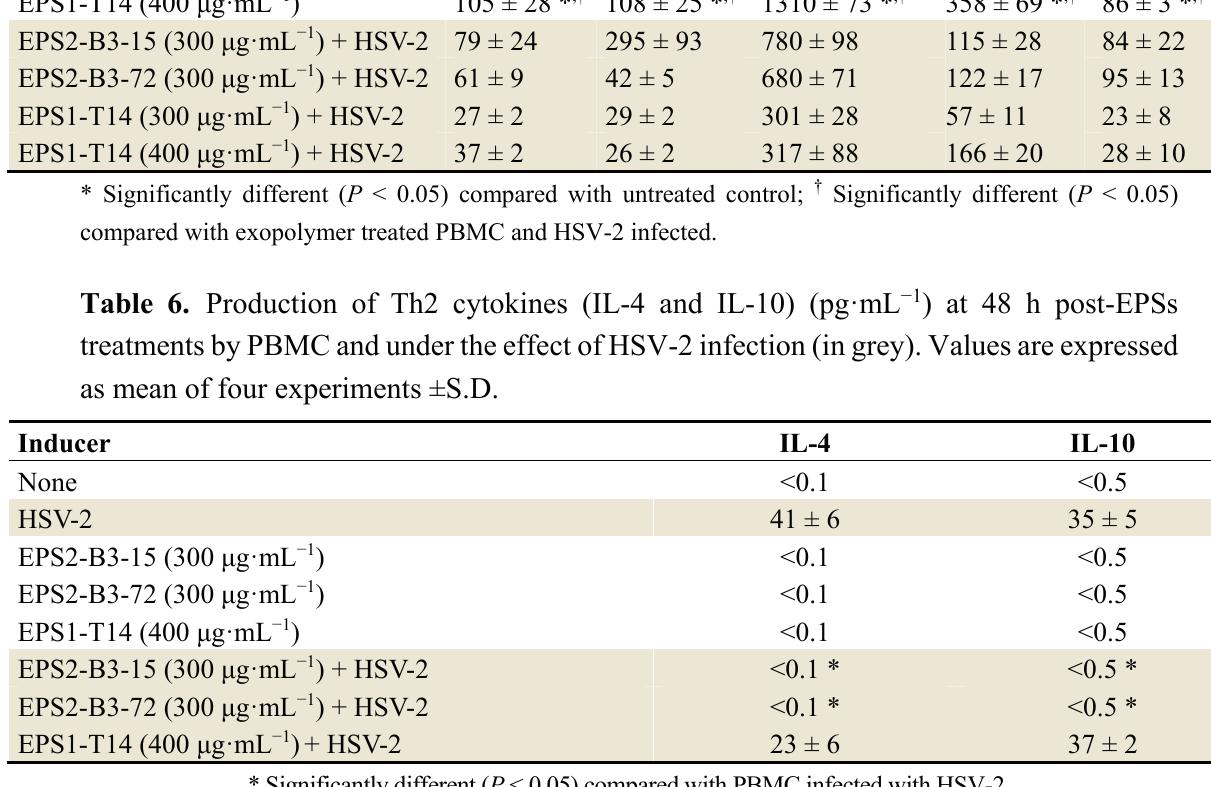
* Significantly different ( P ˂ 0.05) compared with PBMC infected with